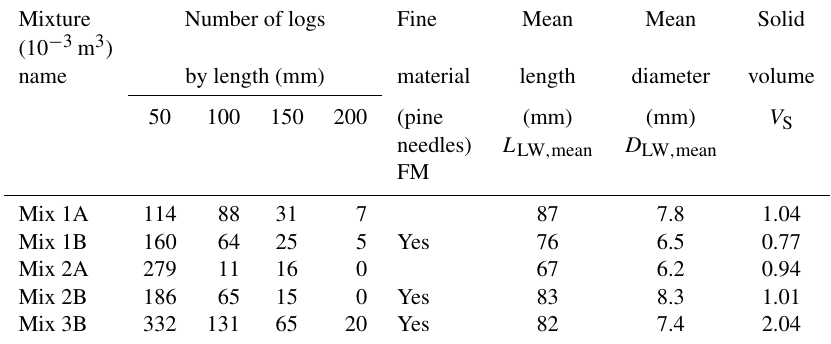
Table 1. LW mixtures